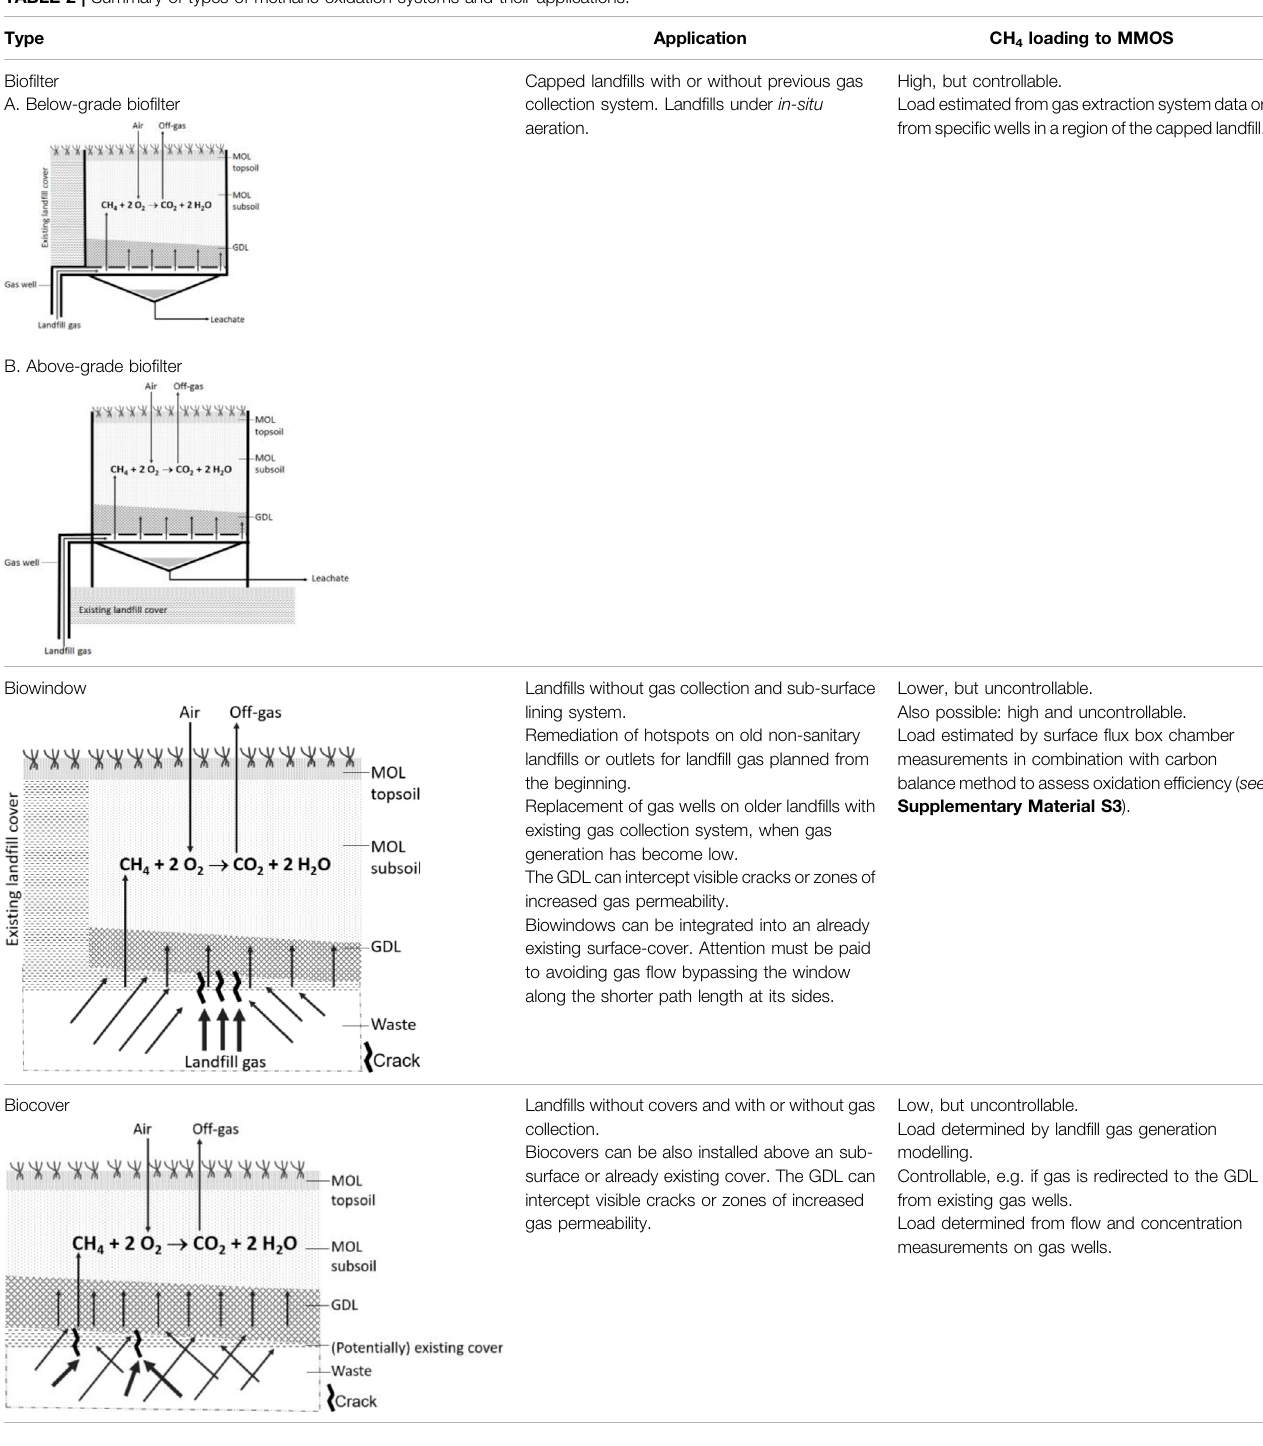
TABLE 2 | Summary of types of methane oxidation systems and their